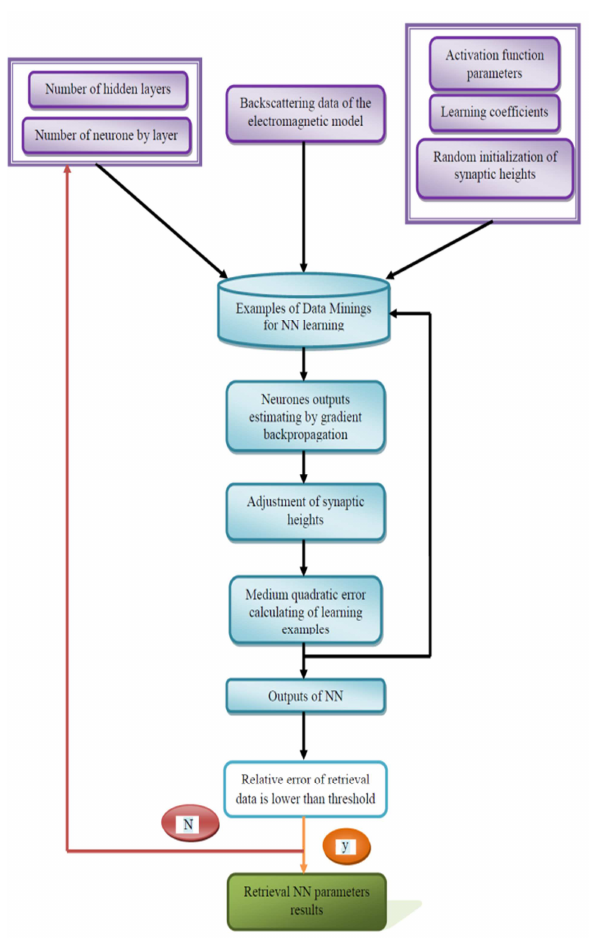
Figure 14. The proposed methodology